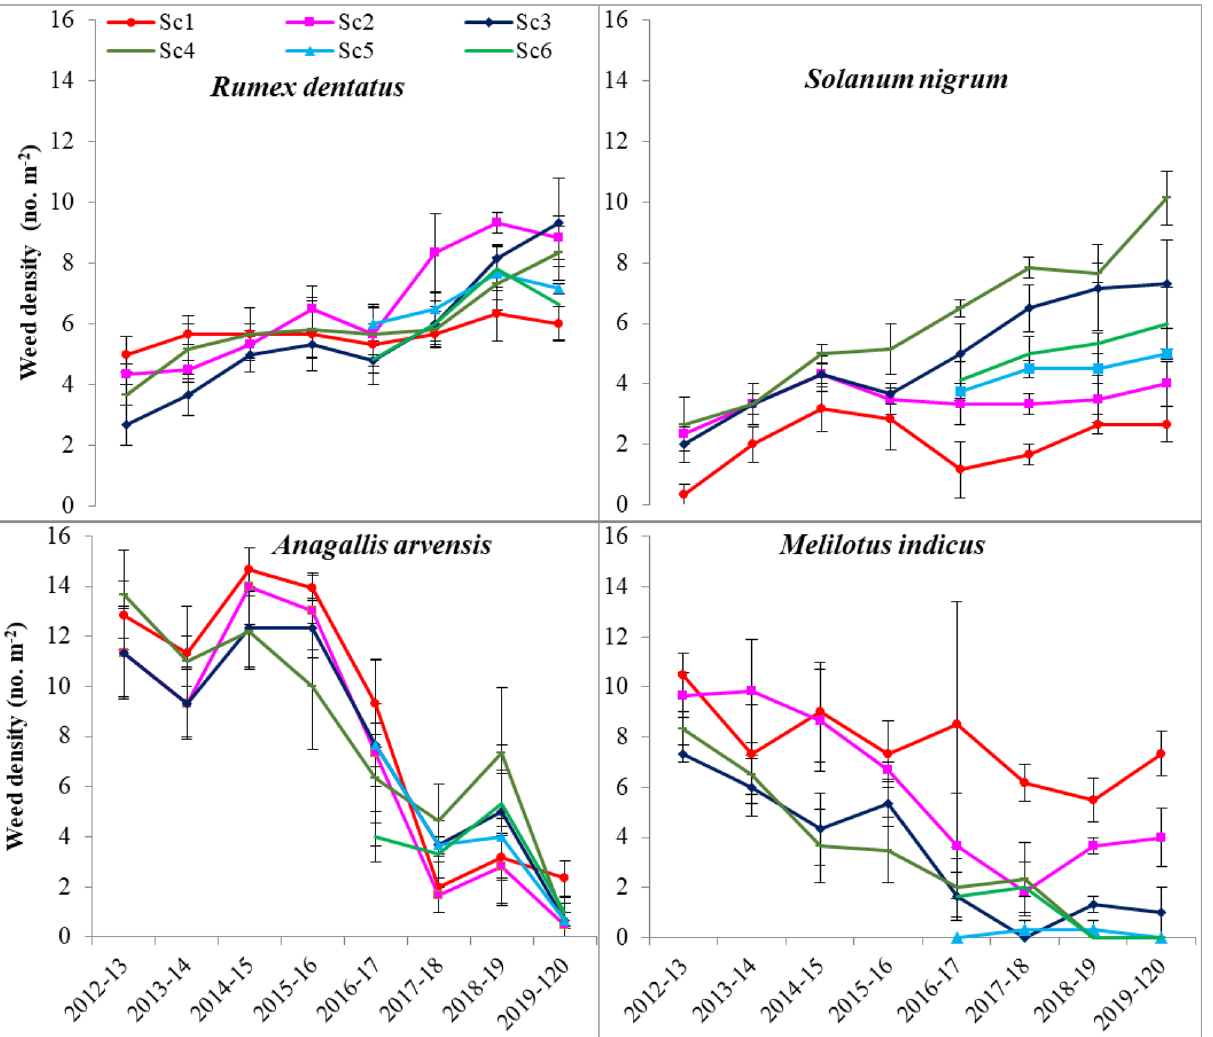
Figure 5. Density (no. m −2 ) of Rumex dentatus, Solanum. nigrum, Anagallis arvensis and Melilotus indicus as influenced by climate smart agriculture-based management practices under wheat crop. Vertical bars indicate ± SE of mean. Sc1 conventional rice–wheat system with flood irrigation (FI), Sc2 conservation agriculture (CA)-based rice–wheat–mungbean system with FI, Sc3 partial CSA-based rice–wheat–mungbean system with FI, Sc4 partial CSA-based maize–wheat–mungbean system with FI, Sc5 full CSA-based rice– wheat–mungbean system with subsurface drip irrigation (SDI), Sc6 full CSA-based maize–wheat–mungbean system with SDI. The figure has been generate using Microsoft Excell office professional Plus (2010), version